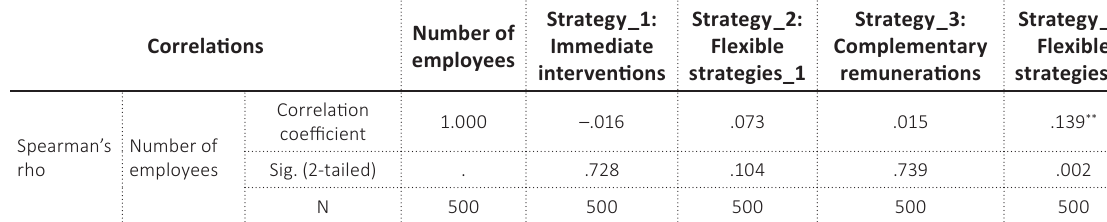
Source: Own research (SPSS